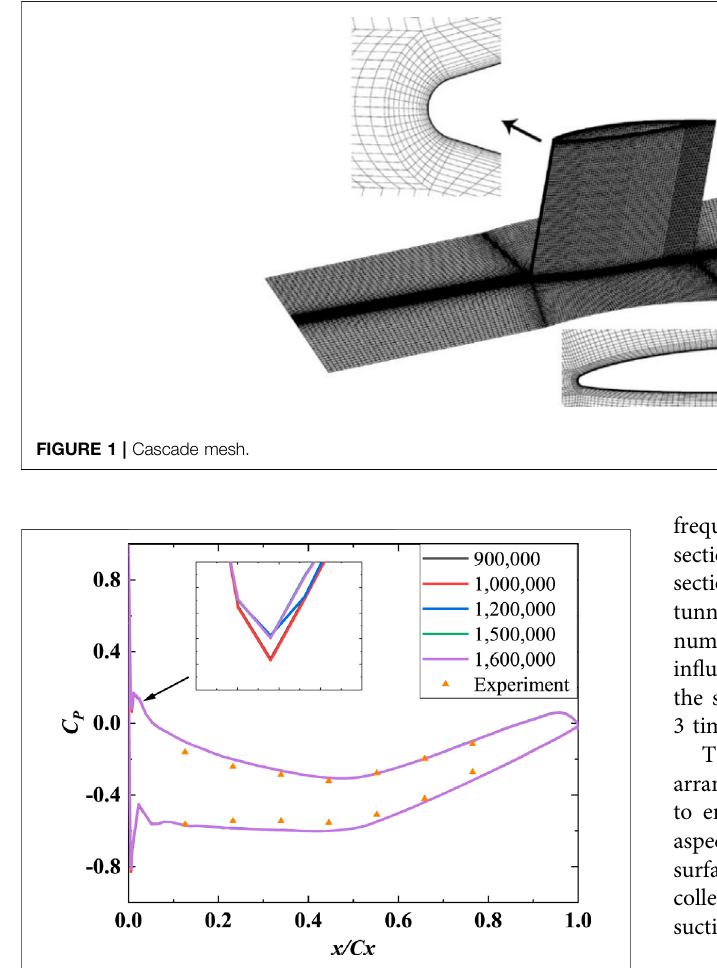
FIGURE 2 | Mesh independence validation.